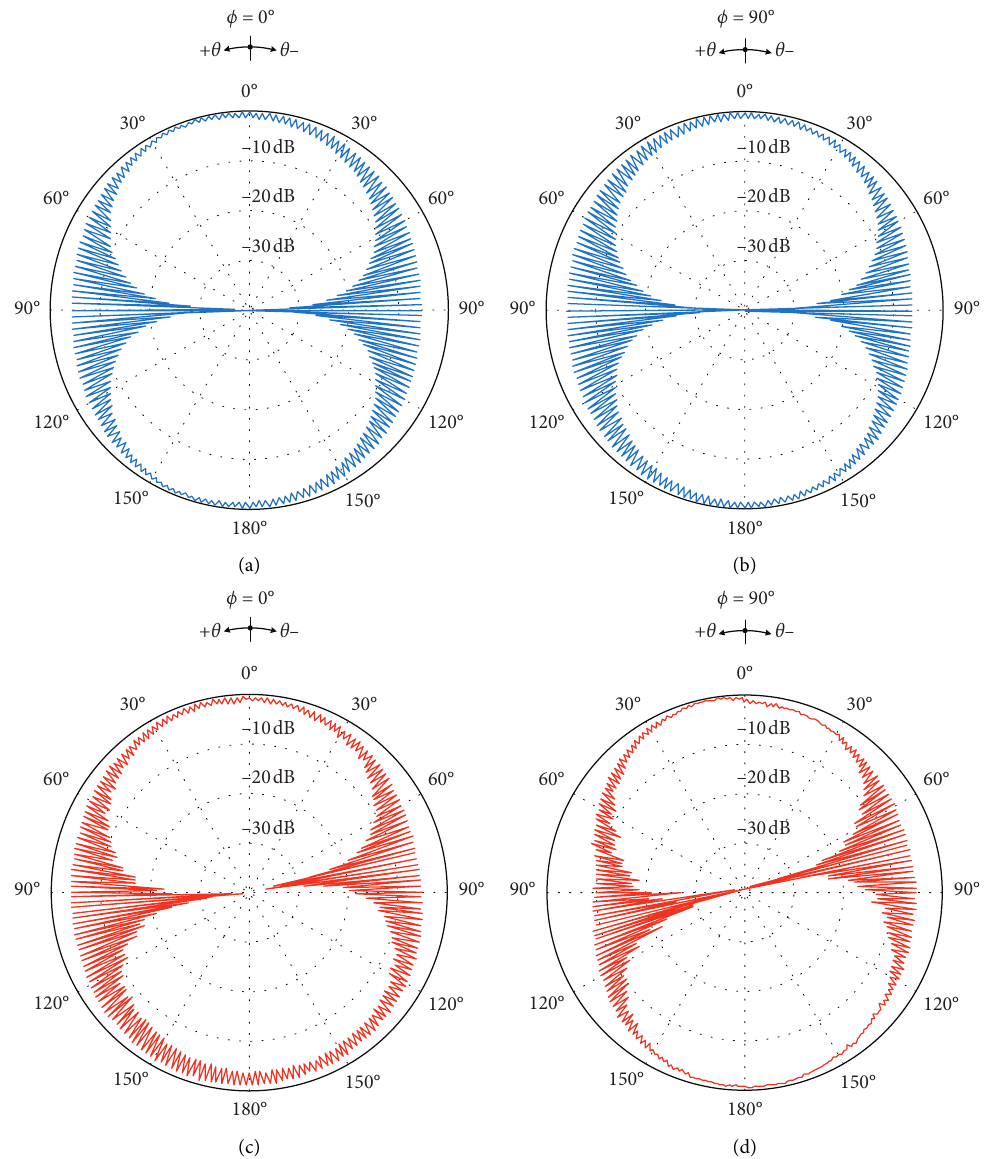
Figure 18: The simulated and measured results of normalized AR pattern of UHF-RFID tag antenna: (a, b) simulated xz -plane and yz -plane; (c, d) measured xz -plane and yz -plane.